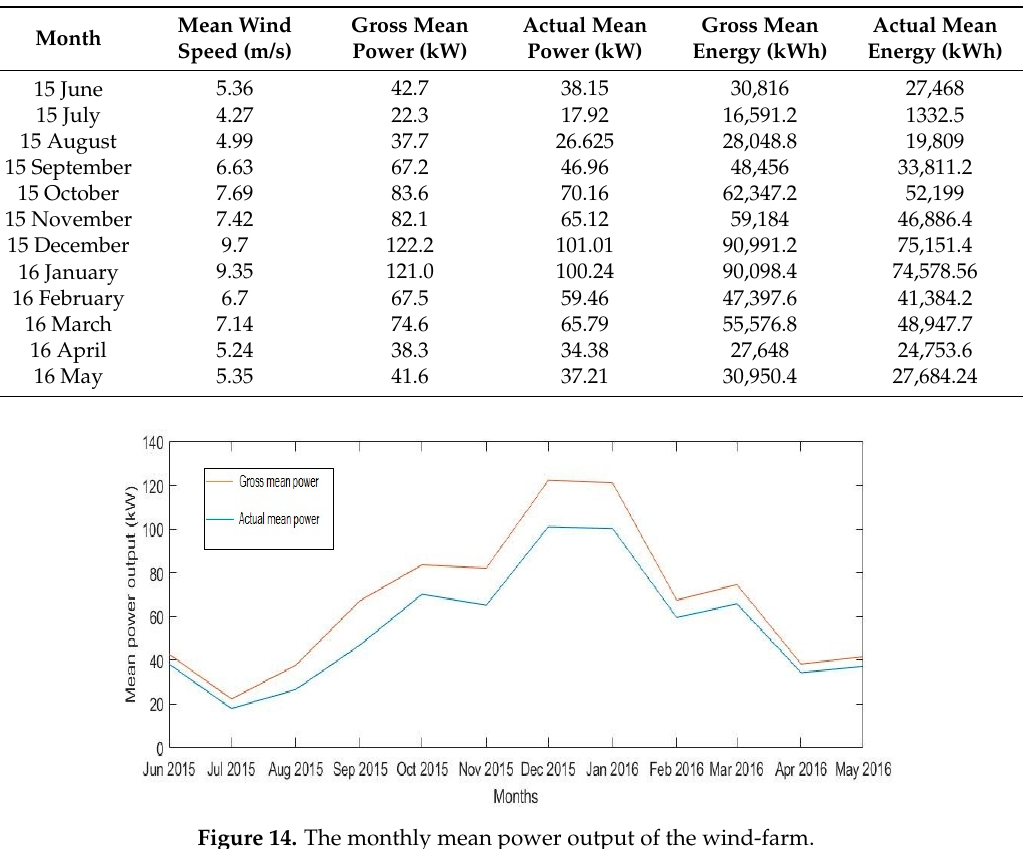
Table 6. Monthly mean power and energy output data.